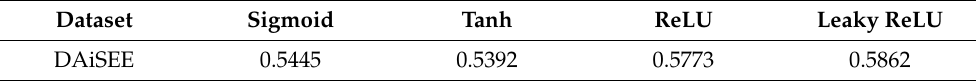
Table 4. Comparison of the accuracy of ShuffleNet v2 with different activation functions.